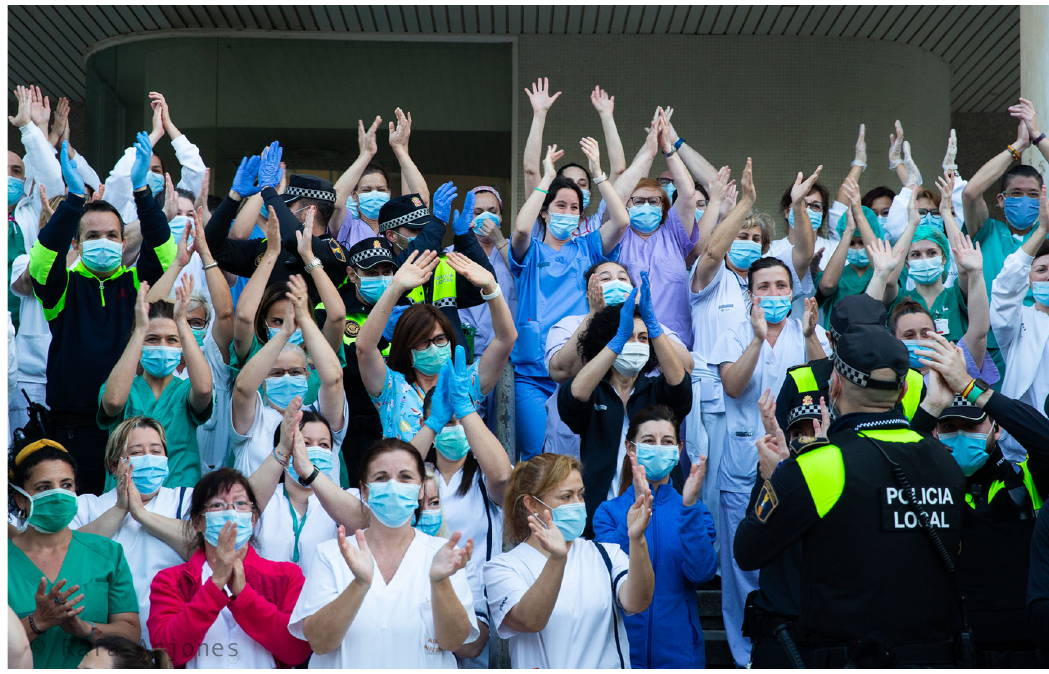
Figure 13. During the confinement, a social phenomenon became widespread, which was intended to show theappreciationofthepopulationforthehospitalworkers:clapping. Inresponsetothisphenomenon,hospital workers would go out to the hospital gates to clap and express their gratitude to the population for its social behaviour. This figure has been reproduced with kind permission of the author.